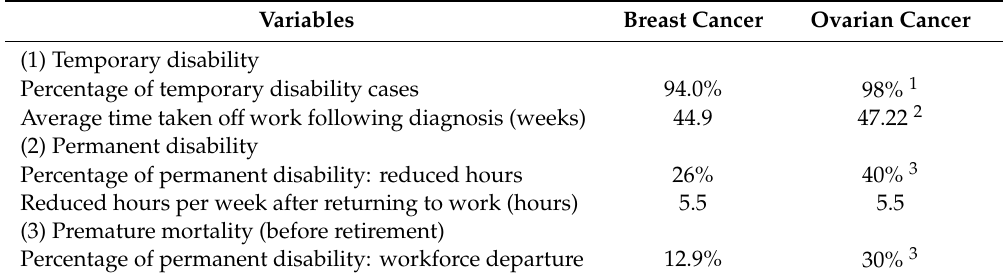
Table A4. Descriptive statistics for productivity loss in breast and ovarian cancer patients.